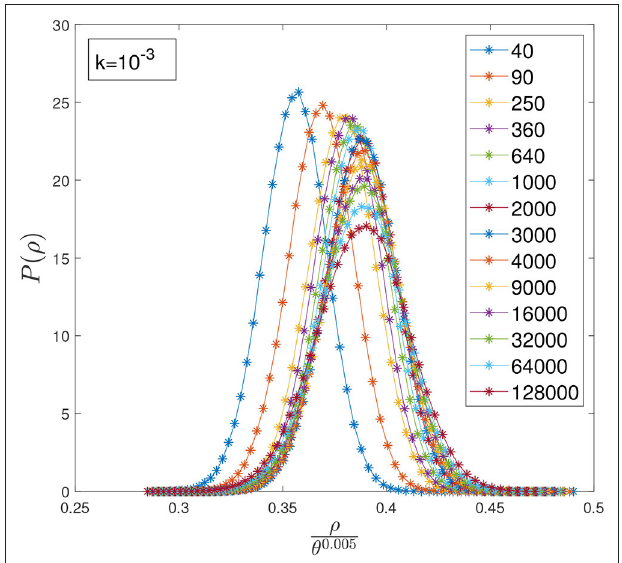
FIGURE 6 | Data collapse for the distribution of densities P ( ρ ) and k = 10 − 3 obtained by inputting the estimated values of µ and σ into a Gaussian distribution. The x-axis and the y-axis have been rescaled in order to make all the curves collapse on a standard normal distribution.